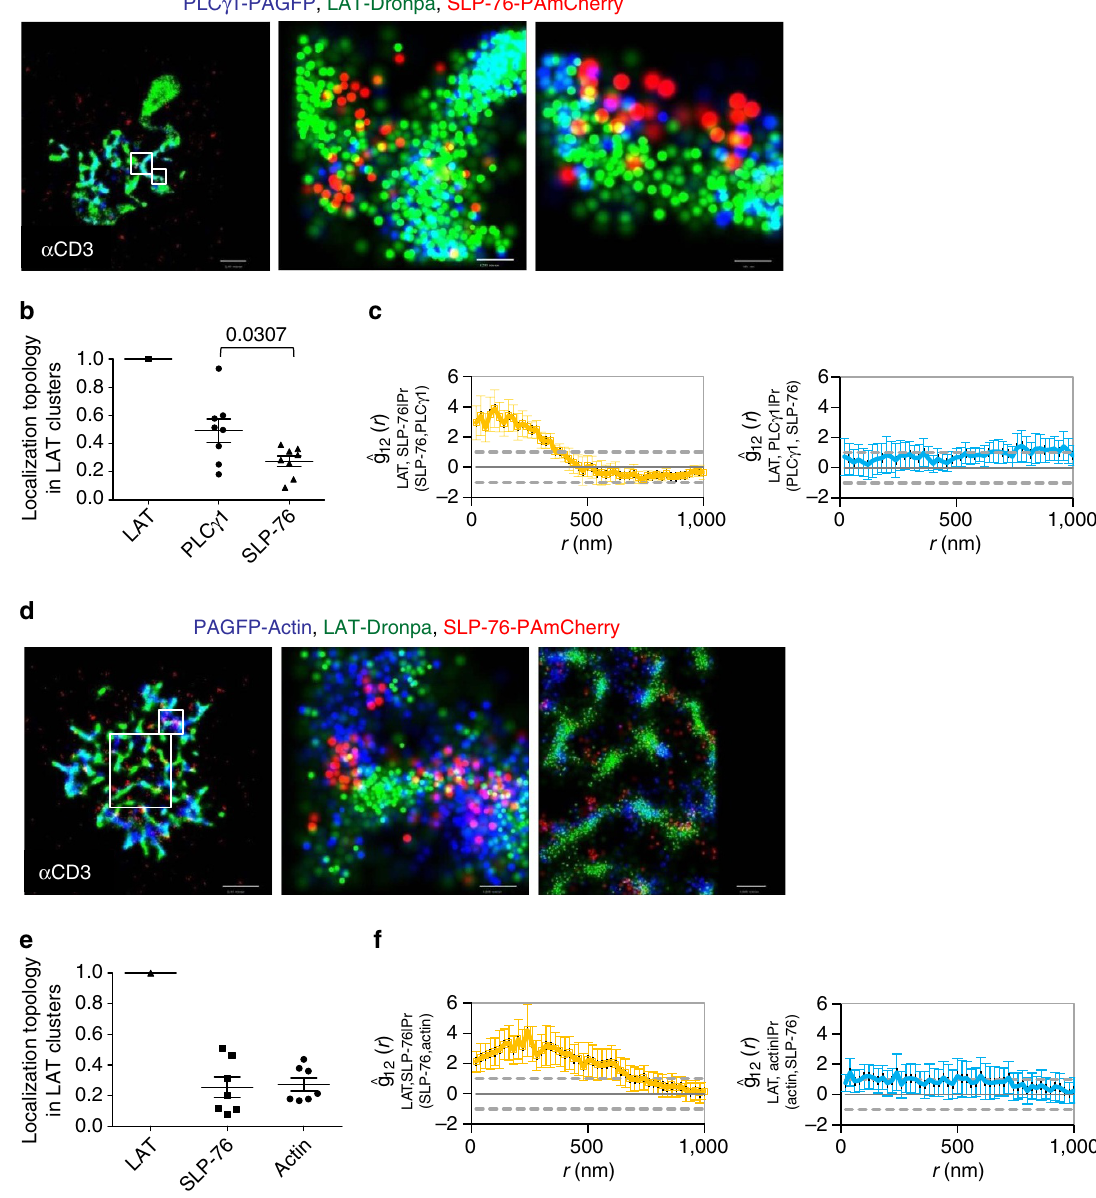
Figure 4 | Hierarchical recruitment of PLC c 1, SLP-76 and actin to LAT clusters. ( a – c ) Hierarchical recruitment of PLC g 1 and SLP-76 to LAT clusters. ( a ) MC-PALM imaging of fixed Jurkat cells expressing PLC g 1-PAGFP (blue), LAT-Dronpa (green) and SLP-76-PAmCherry (red), spread on an a CD3-coated coverslips for 3min before fixation. Two zoomed images of representative LATclusters are shown. ( b ) Topology analyses in multiple cells ( n ¼ 8) imaged as in a . P value was calculated using a two-tailed t -test for unequal variances. ( c ) A conditional bivariate PCF (standardized) analysing the interaction synergy of SLP-76 and PLC g 1 on the binding of SLP-76 to LAT (left) or the interaction synergy of PLC g 1 and SLP-76 on the binding of PLC g 1 to LAT (right). Maximal probability density values for PAGFP, Dronpa and PAmCherry rendering—( a ) 190, 390, 340 molecules per m m 2 , respectively. Scale bars, 2 m m (left); 200nm (middle); and 100nm (right). ( d – f ) Actin promotes the nanoscale patterning of LATclusters. ( d ) MC-PALM imaging of fixed Jurkat cells expressing PAGFP-actin (blue), LAT-Dronpa (green) and SLP-76-PAmCherry (red), spread on an a CD3-coated coverslips for 3min before fixation. Two zoomed images of representative LATclusters are shown. Maximal probability density values for PAGFP, Dronpa and PAmCherry rendering 310, 330, 290 molecules per m m 2 , respectively. Scale bar, 2 m m (left); 200nm (middle); and 500nm (right). ( e ) Topology analyses of molecular patterning in multiple cells imaged as in a ( n ¼ 7). ( f ) A conditional bivariate PCF (standardized) analyses of the interaction synergy of SLP-76 and actin on the binding of SLP-76 to LAT (left) or the interaction synergy of actin and SLP-76 on the placement of actin with respect to LAT (right). Error bars are was significant corresponded to the effective range over which recruitment of red molecules to green molecules was promoted by clustering and synergic interactions were simulated (see arrow- the presence of blue molecules. Indeed, our interaction synergy heads in Fig. 5d,e and Supplementary Information for further statistics accurately captured significant synergy between green details). Note that we show here both the conditional PCF and blue molecules in their recruitment of red molecules, as g 12|Pr(2,3) (Fig. 5d) and its standardized form gˆ 12|Pr(2,3) (Fig. 5e), indicated by the PCFs (Fig. 5d,e). The length scale where synergy